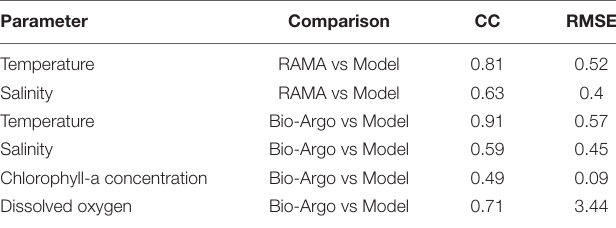
TABLE 2 | The correlation coefficient (CC) and root mean square error (RMSE) for model-simulated parameters against in situ measurements (shown in Figure 4